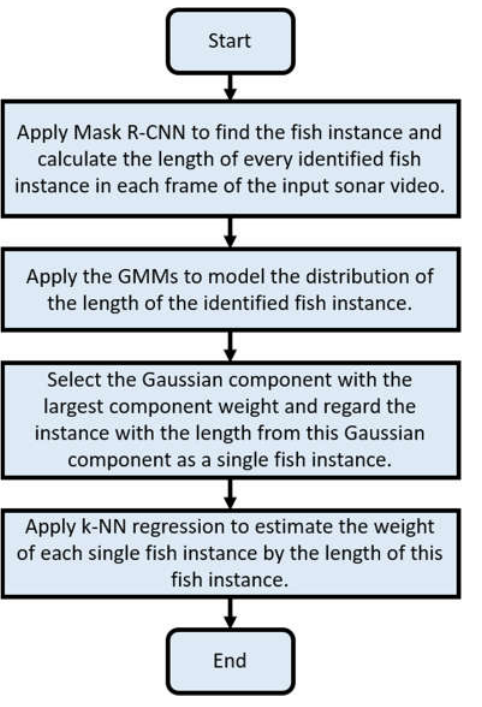
Figure 12. The flowchart to estimate the fish length and weight distribution.